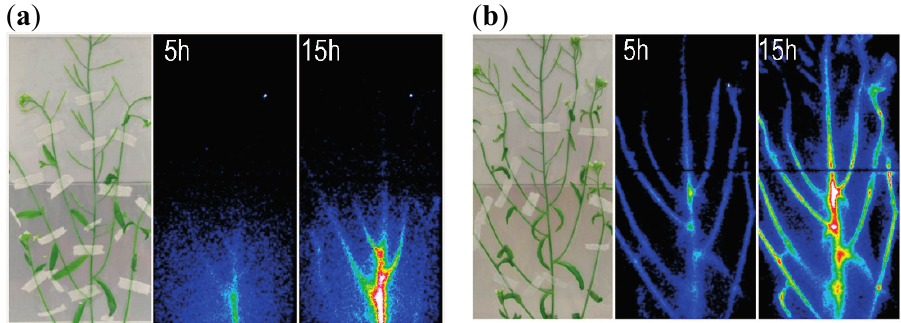
Figure 1. RRIS (real-time radioisotope imaging system [89,90]) captured each radionuclide image at 5 and 15 h of root absorption of ( a ) 28 Mg; ( b ) 32 P phosphate. Arabidopsis thaliana (Columbia 0) was grown with nutrient solution for 43 days under a light/dark cycle of 16 h/8 h at 22